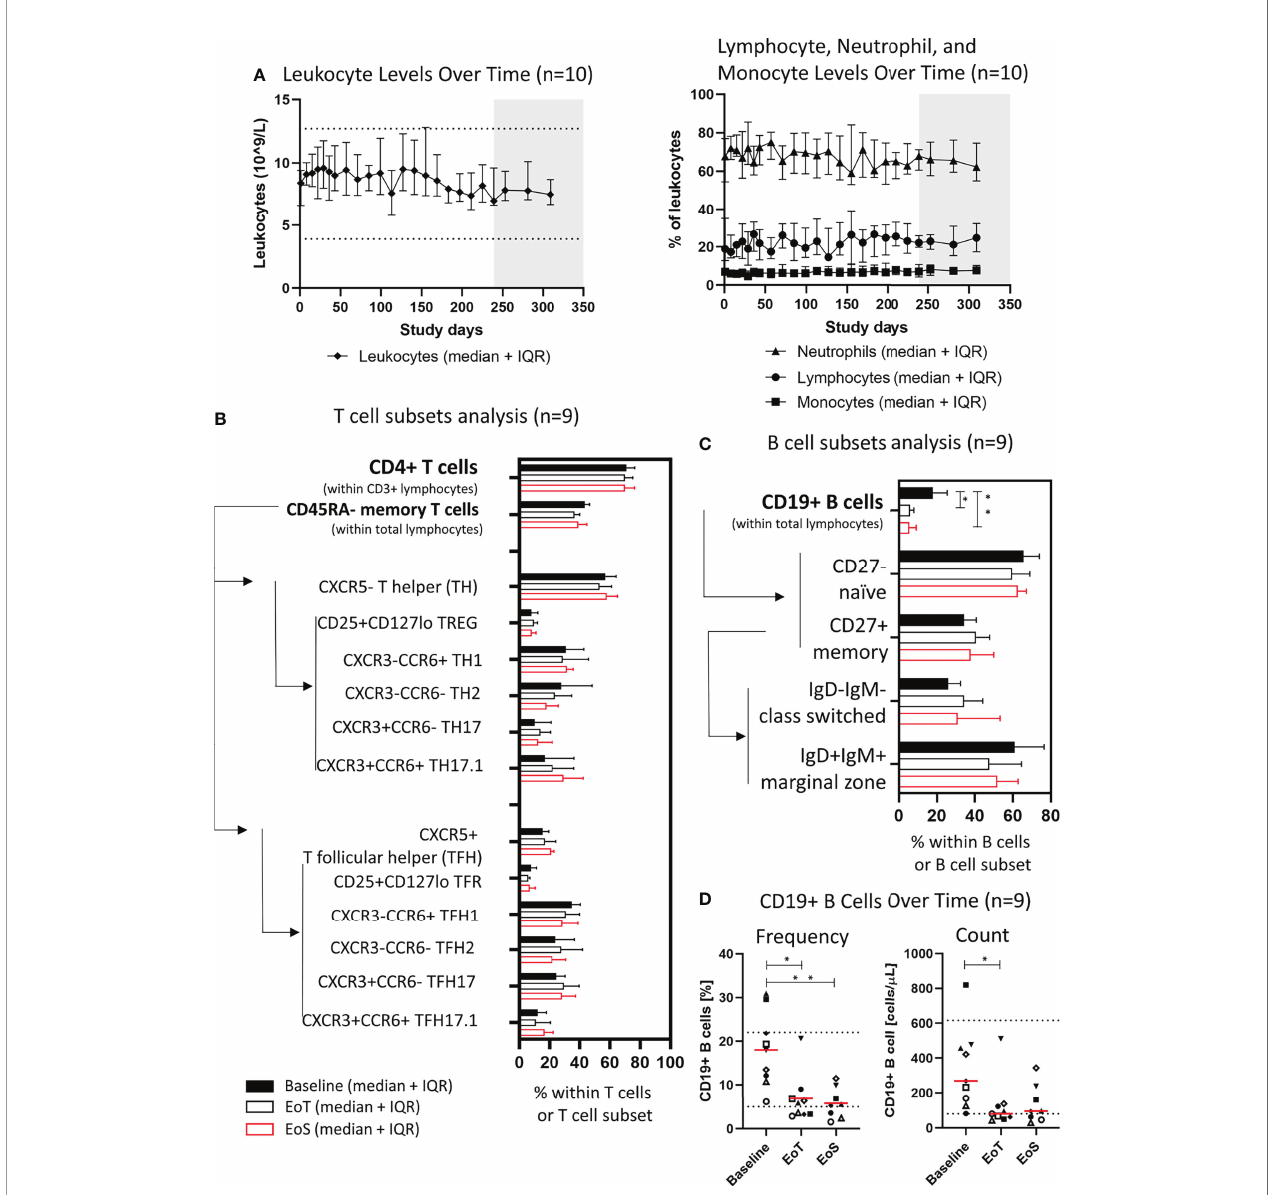
FIGURE 3 | Efgartigimod does not affect frequencies of lymphocyte subsets except B cells. (A) Leukocytes (10 9 /L) and frequency (%) of neutrophils, lymphocytes, and monocytes within leukocytes in peripheral blood of cohort 4 participants ( n = 10), median, and IQR are plotted. (B) Frequency of CD4+ T cells within lymphocytes and their subsets of cohort 4 participants with viable PBMC ( n = 9), median, and IQR are plotted. (C) Frequency of CD19+ B cells within lymphocytes and their subsets of cohort 4 participants with viable PBMC ( n = 9), median, and IQR are plotted. Arrows and lines indicate the way the frequency of a parent population was determined. (D) Frequency and counts of CD19+ B cells at baseline, EoT, and EoS of cohort 4 participants with viable PBMC and sustained clinical response ( n = 9). Red lines represent medians and dotted lines represent normal limits. A non-parametric one-way ANOVA with Dunn ’ s post-test was performed. * p ≤ 0.05; ** p ≤ 0.01. EoT, end of treatment; EoS, end of study; IQR, interquartile